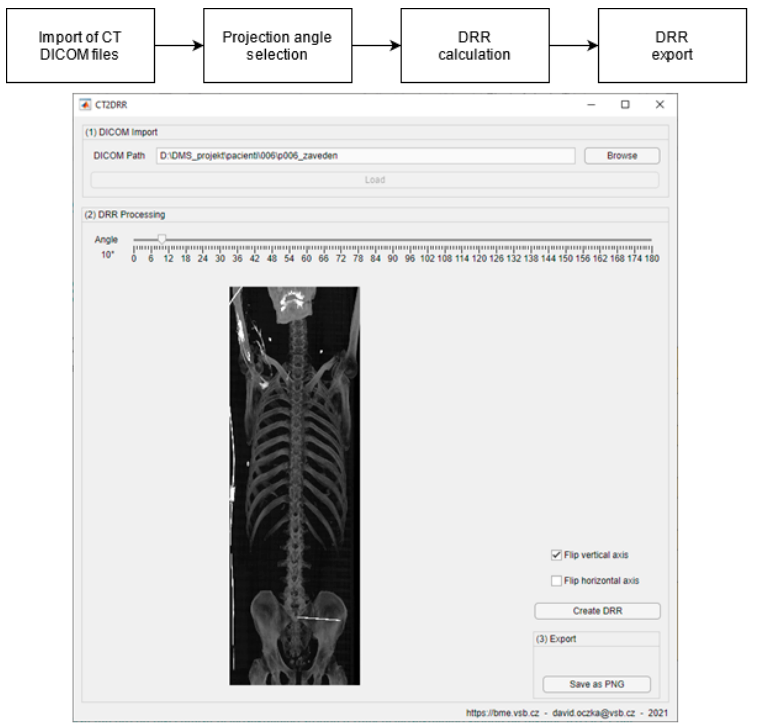
Figure 4. Block diagram of the process of generation DRR projections and proposed software for generating DDR projections.